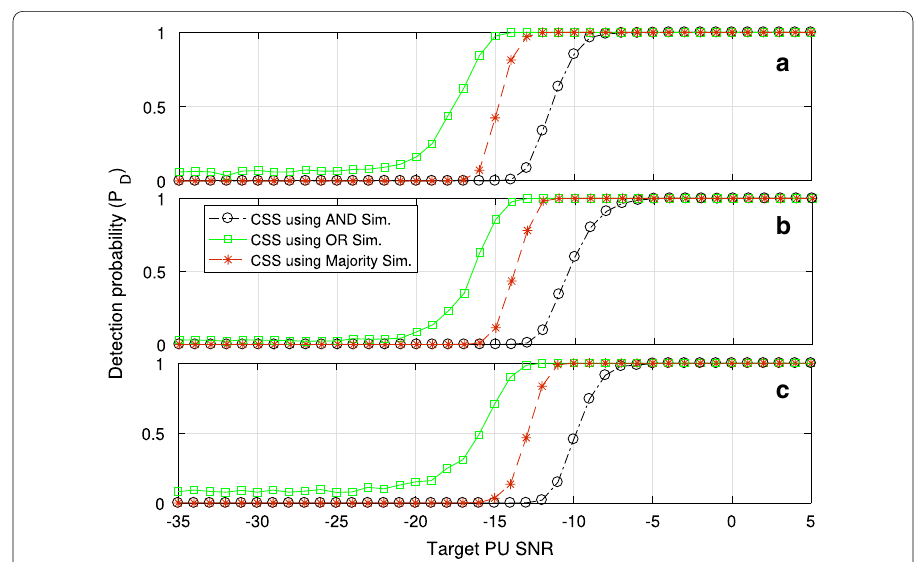
Fig. 7 CSS detection probabilities with a Max–Min ED, b Max/Min ED and c Diff. Max–Min ED and three different linear fusion rules for non-oversampled QPSK PU signal under Indoor channel and log-normal fading ( σ = 9dB ), the length of N FFT = 8 , the number of sensing stations M and 1 dB